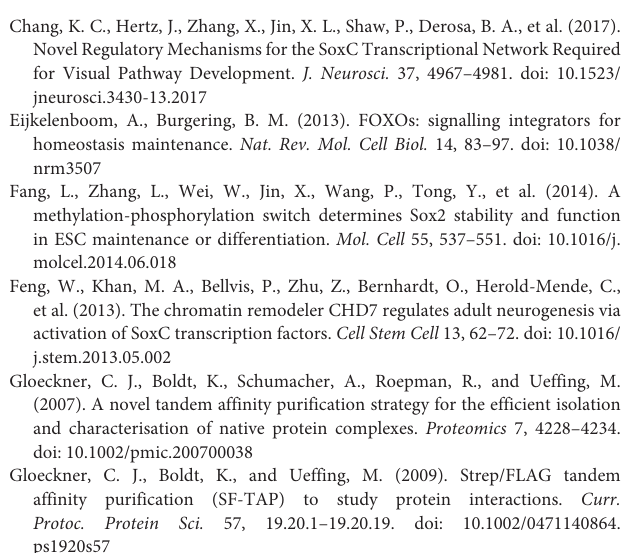
TABLE S2 | Statistical analysis of the subcellular distribution of each SOX11 mutant relative to SOX11 WT. Data from Figures 5 , 6 were analyzed for their significant differences with multiple comparison One-Way ANOVA, carried out with GraphPad Prism. The statistical comparisons of the samples are represented by ( ∗ ) for significant differences and with (ns) for not significant differences as also shown by the given p -values ( ∗ p < 0.05, ∗∗ p < 0.01, ∗∗∗ p <